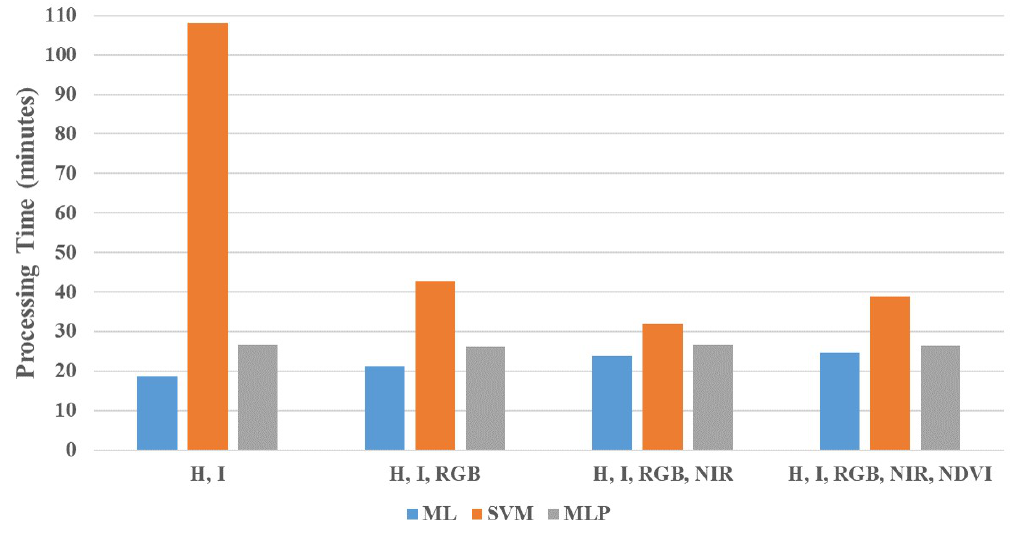
Figure 15. Processing